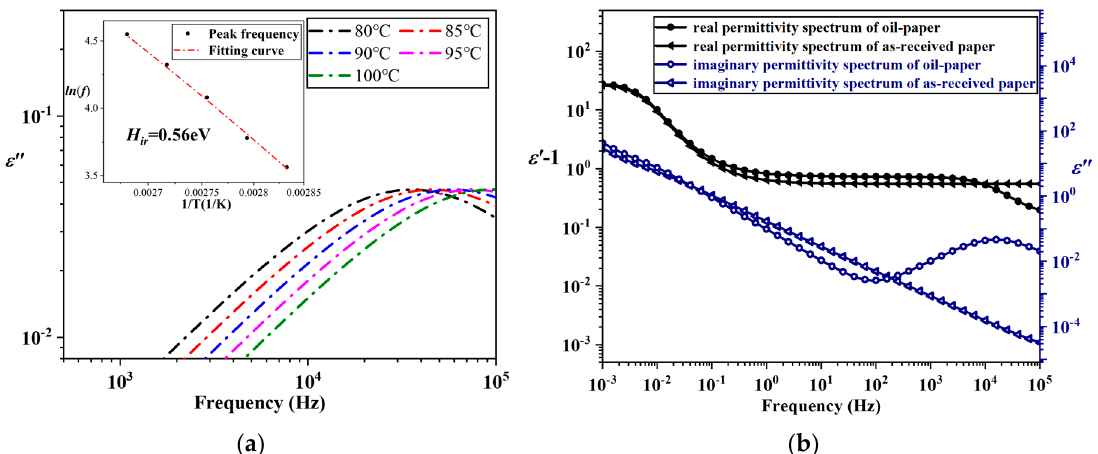
Figure 10. Related experimental data and analysis of the interfacial relaxation of the oil–paper sample in a high-temperature range. ( a ) Independent spectra of interfacial relaxation under different temperatures. ( b ) FDS comparisons between as-received cellulose paper and oil–paper composite sample.